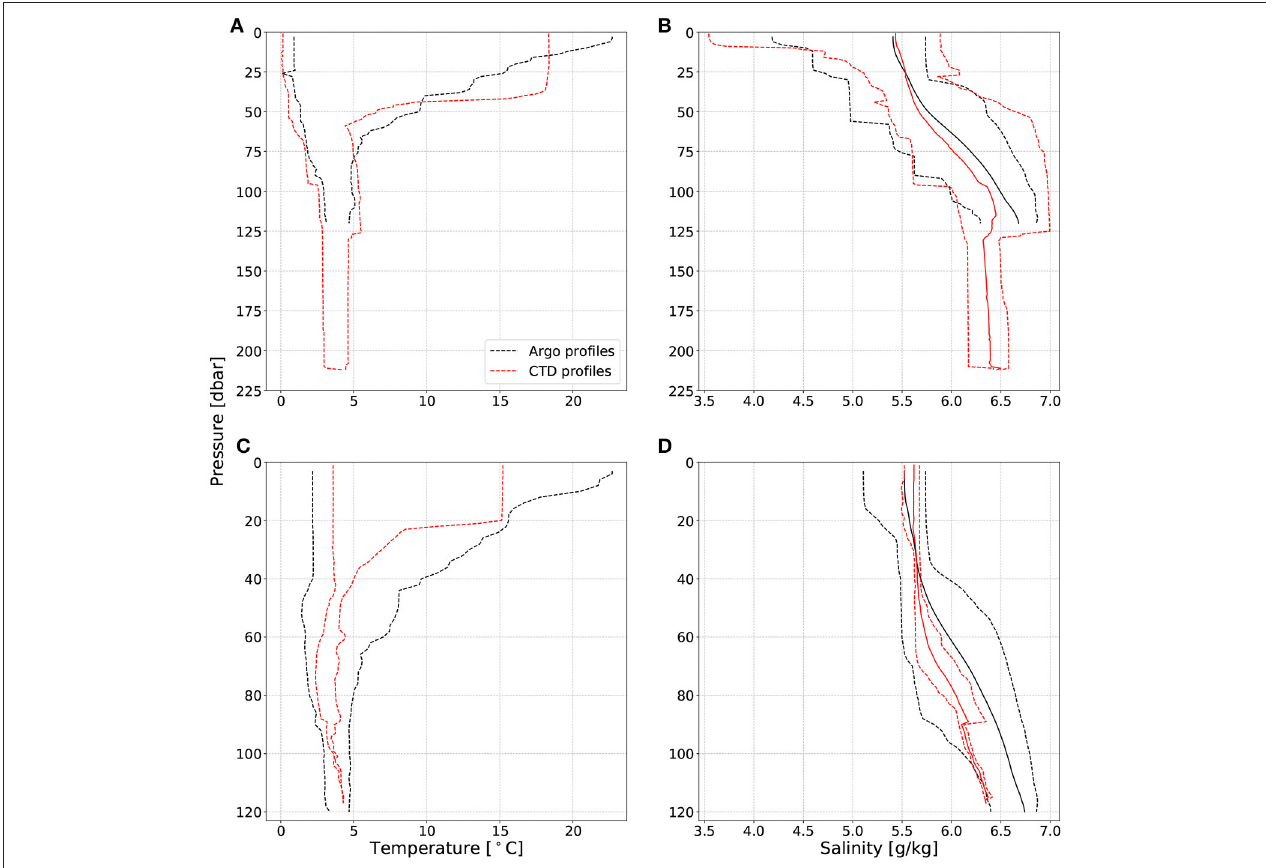
FIGURE 9 | Ranges (dashed lines) and means (solid lines in B,D ) of (A,C) temperature and (B,D) salinity data from Argo data (black) and ship CTD (red) from (A,B) the entire Bothnian Sea and from (C,D) the Argo float deployment area shown as a red rectangle in Figure 1 between 2012 and 2017. The locations of the CTD profiles are also shown in Figure 1